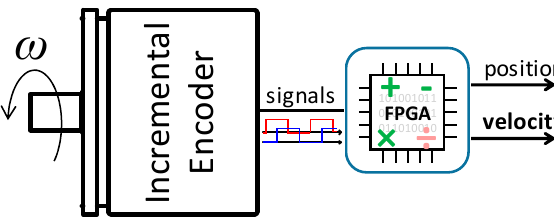
Figure 1. FPGA-based smooth velocity estimation with an incremental encoder.